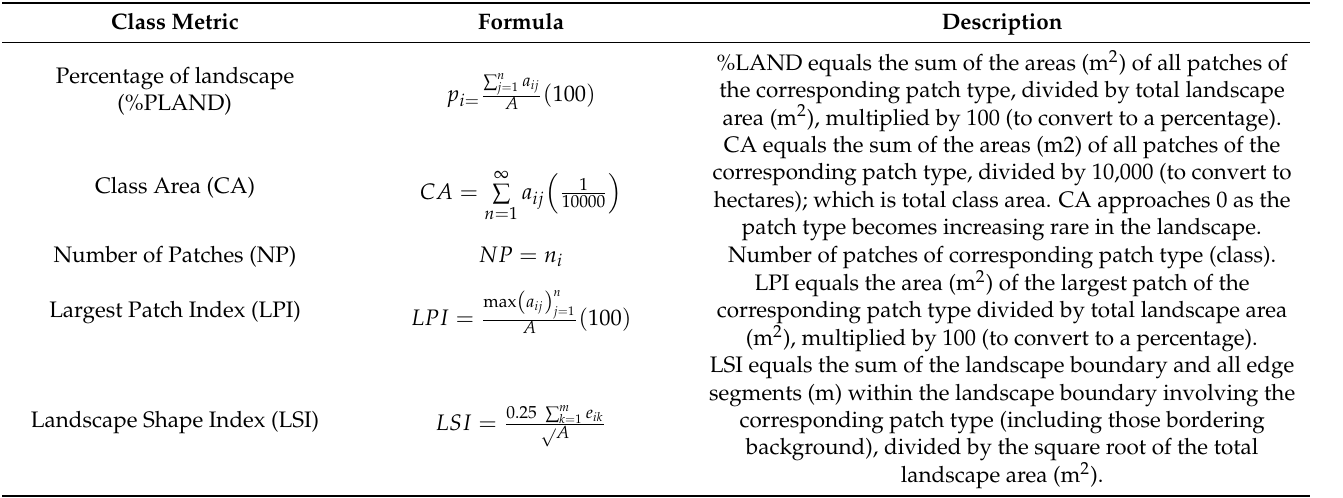
Table 4. Class metrics and descriptions [43–46].